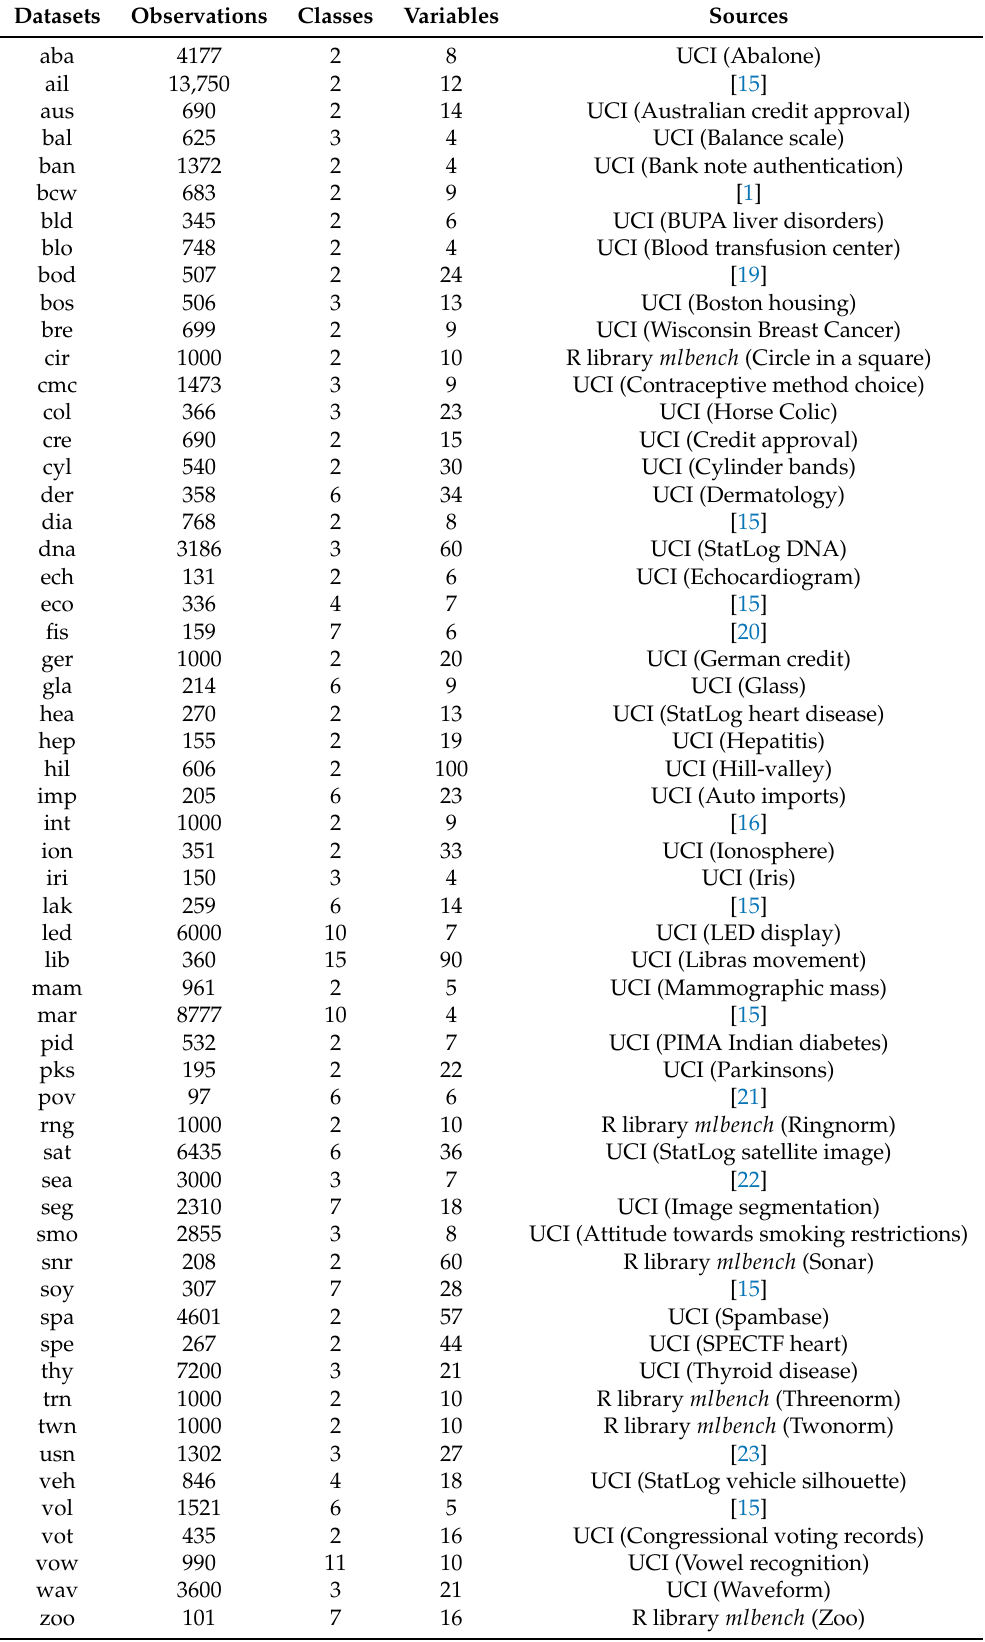
Table 2. The description of 58